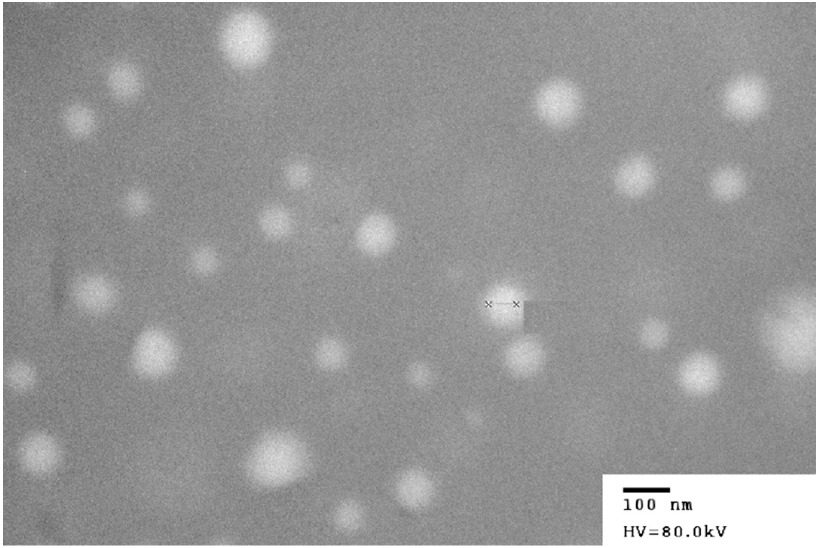
Figure 6. TEM image of the optimized liquid SNEDDS formulation.